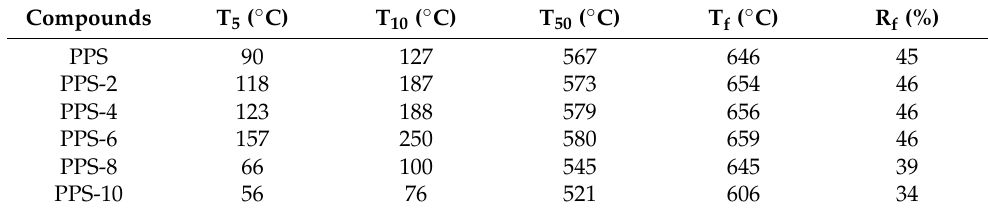
Table 6. TGA data of PPS@BC